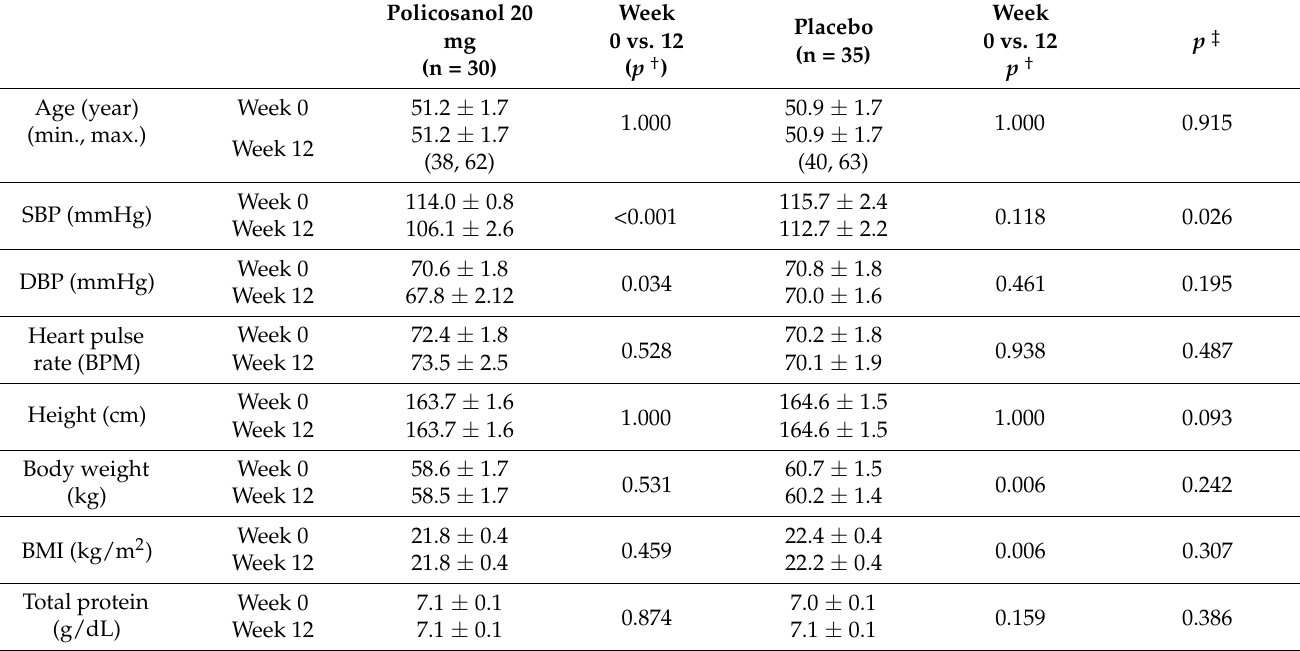
Table 1. Anthropometric profiles and blood parameters between the policosanol (20 mg) and placebo groups